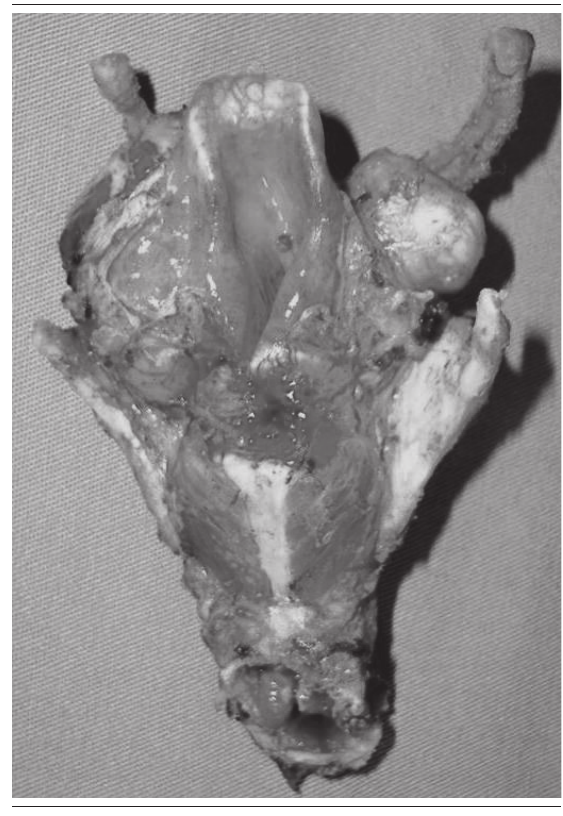
figurE 3 – Surgical specimen (case 2) Total laryngectomy product. Two well-delimited tumors, both occupying the supraglottis and the paraglottis space bilaterally are individualized.